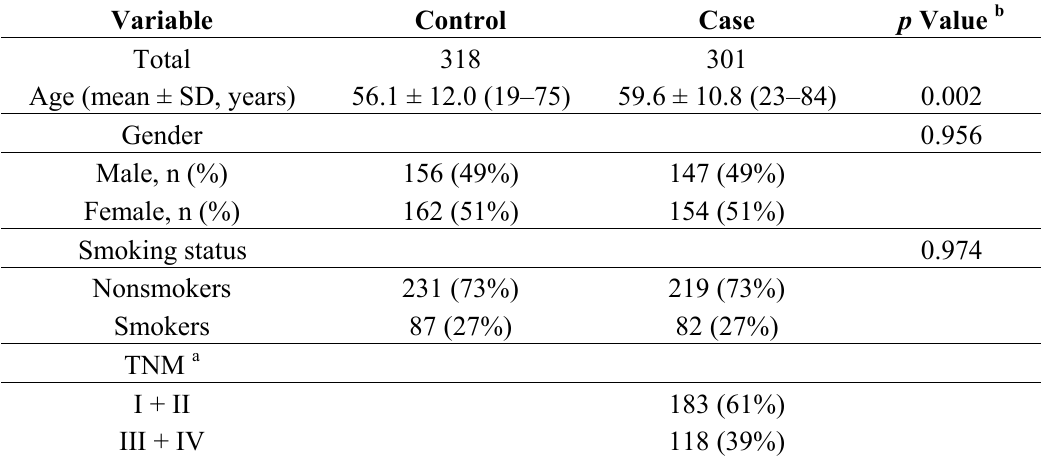
Table 1. Characteristics of controls and cases in a Chinese Han